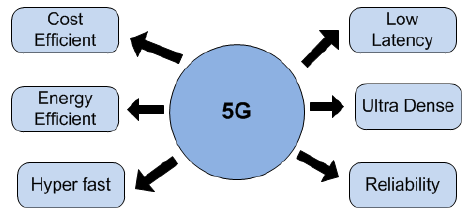
Figure 2. Distinguishing features of 5G.